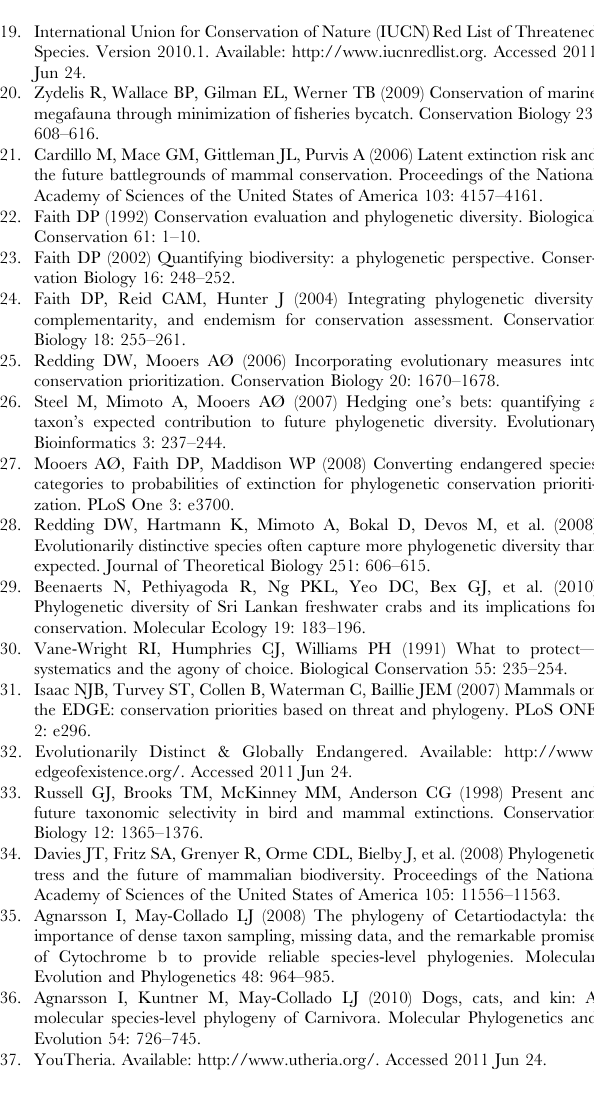
Table S1 Full data set for evolutionary distinctiveness, EDGE and HEDGE calculations using TUATARA (Car- nivores = 387, Cetartiodactyls = 333). Table S2 Consensus list of conservation priority species obtained from the multiple analysis and approaches. In bold are aquatic and semi-aquatic